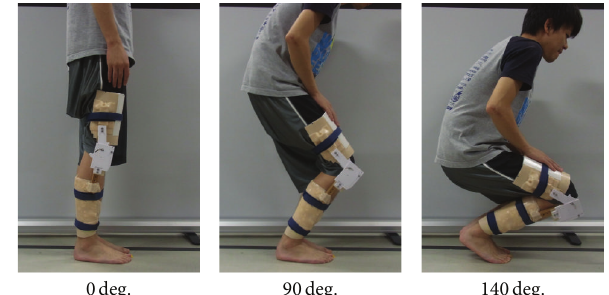
Figure 8: Squat with the knee mechanism.